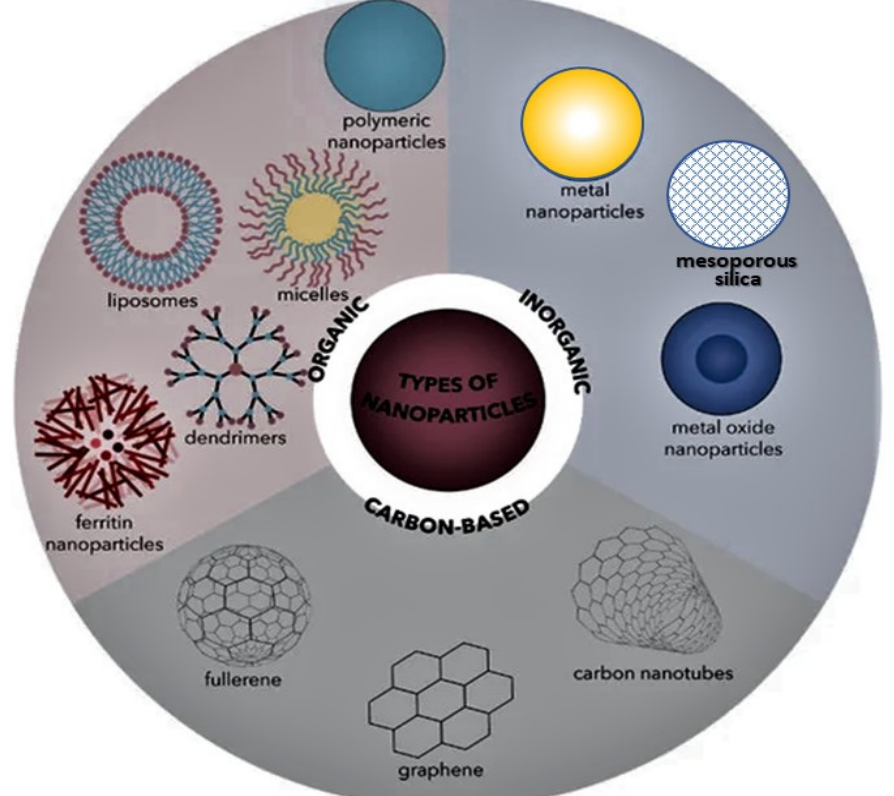
Figure 2. Different types of nanomaterials used as nanofillers in polymeric nanocomposites, catego- rized according to their nature into inorganic, organic and carbon-based.